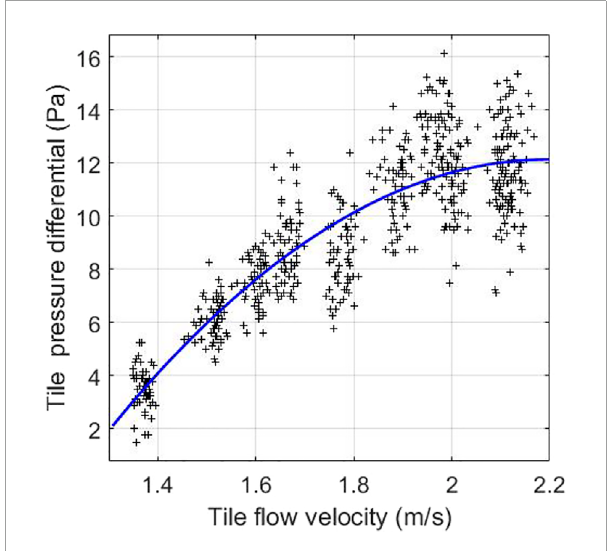
FIGURE 14 The tile airflow velocity vs . tile pressure differential.